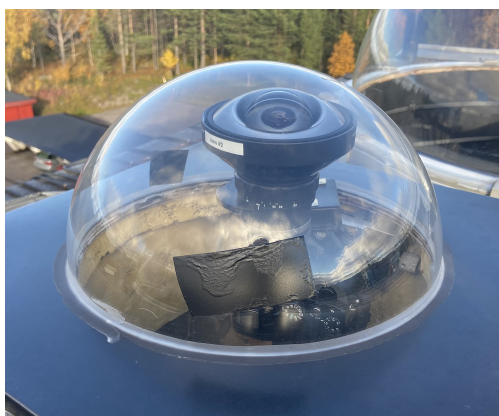
Figure 3. The all-sky camera (ASC) at the Swedish Institute of Space Physics in Kiruna (68 ◦